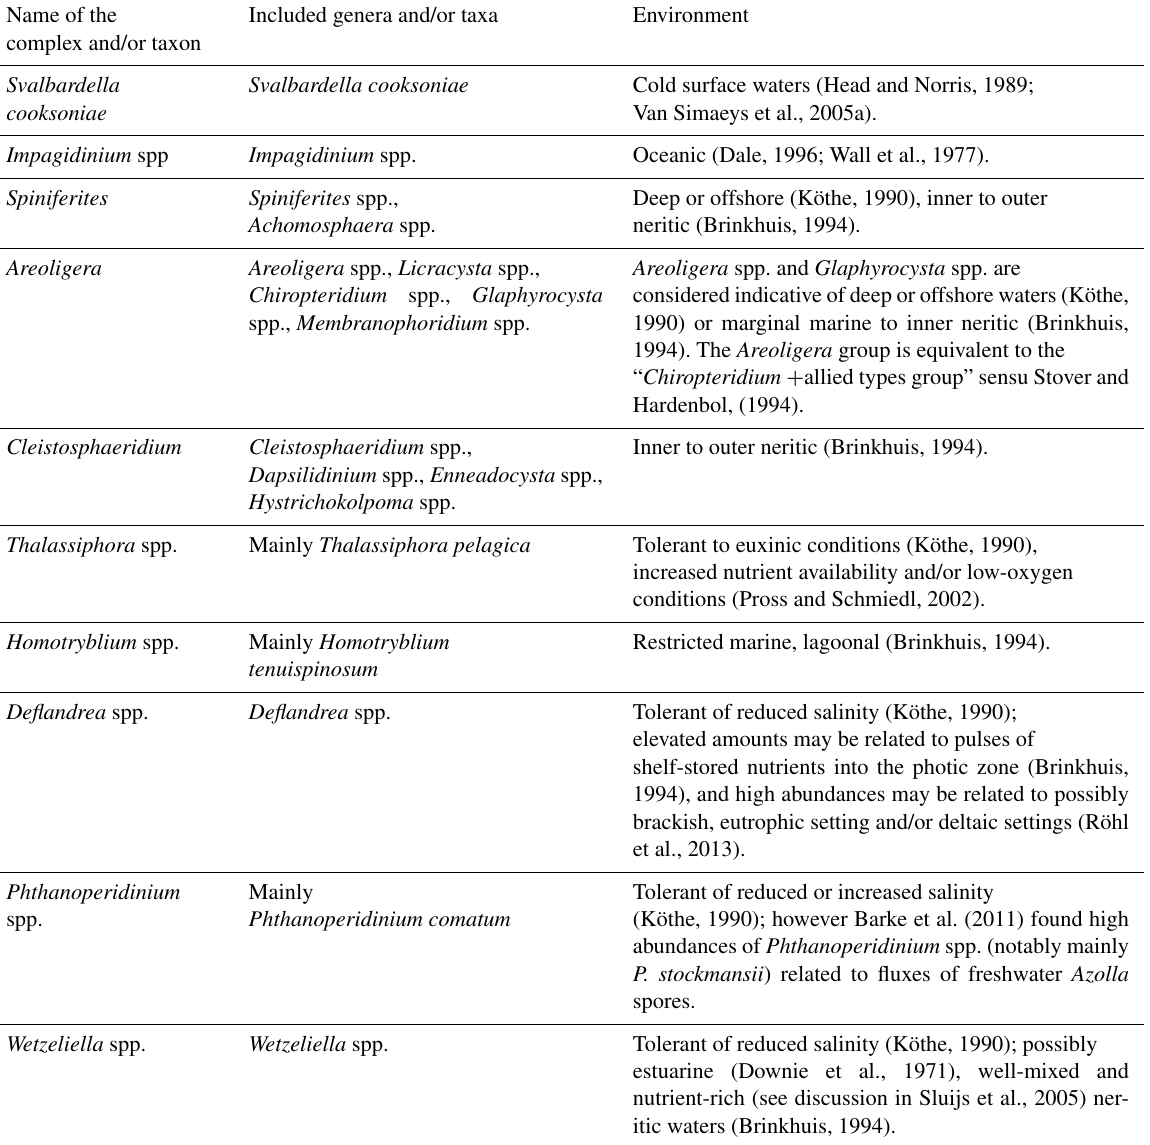
Table 2. Palaeoecological affinities of the selected dinocyst species and complexes discussed in the study. Name of